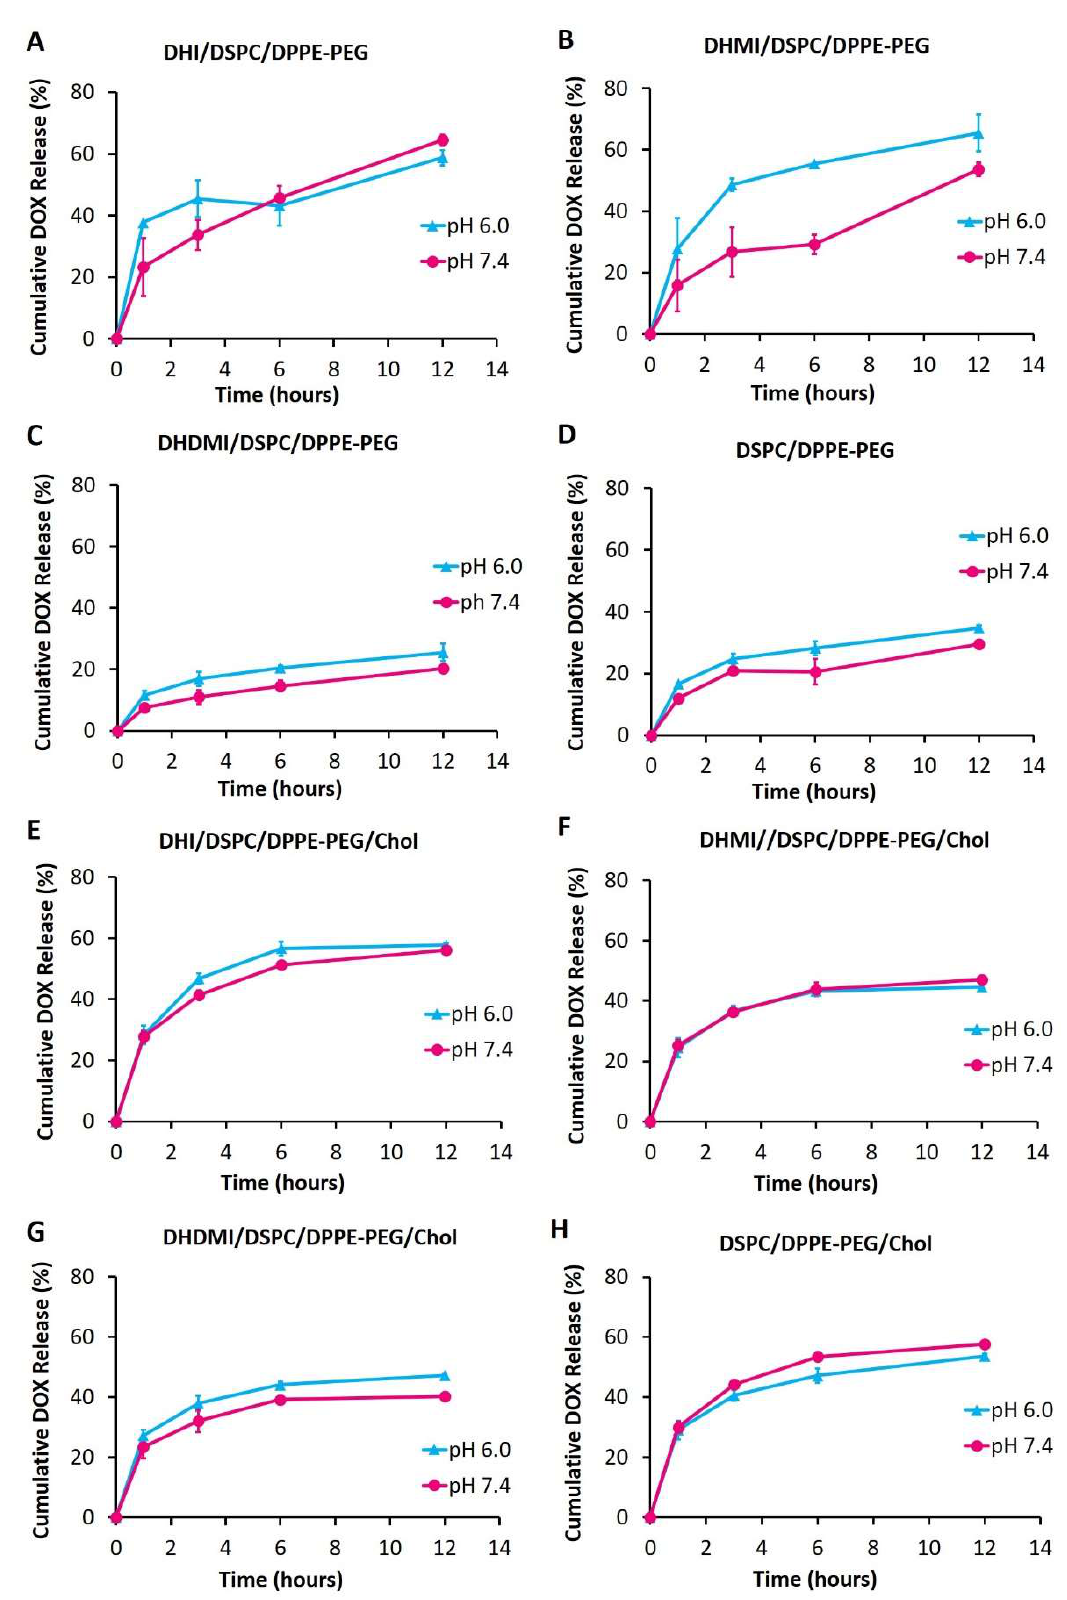
Figure 6. Release of DOX from liposomes without cholesterol ( A – D ) and with 25% cholesterol ( E – H ) over 12 h of incubation at 37 °C, pH 6.0 and 7.4. Data are presented as mean ± SD, N = 3.